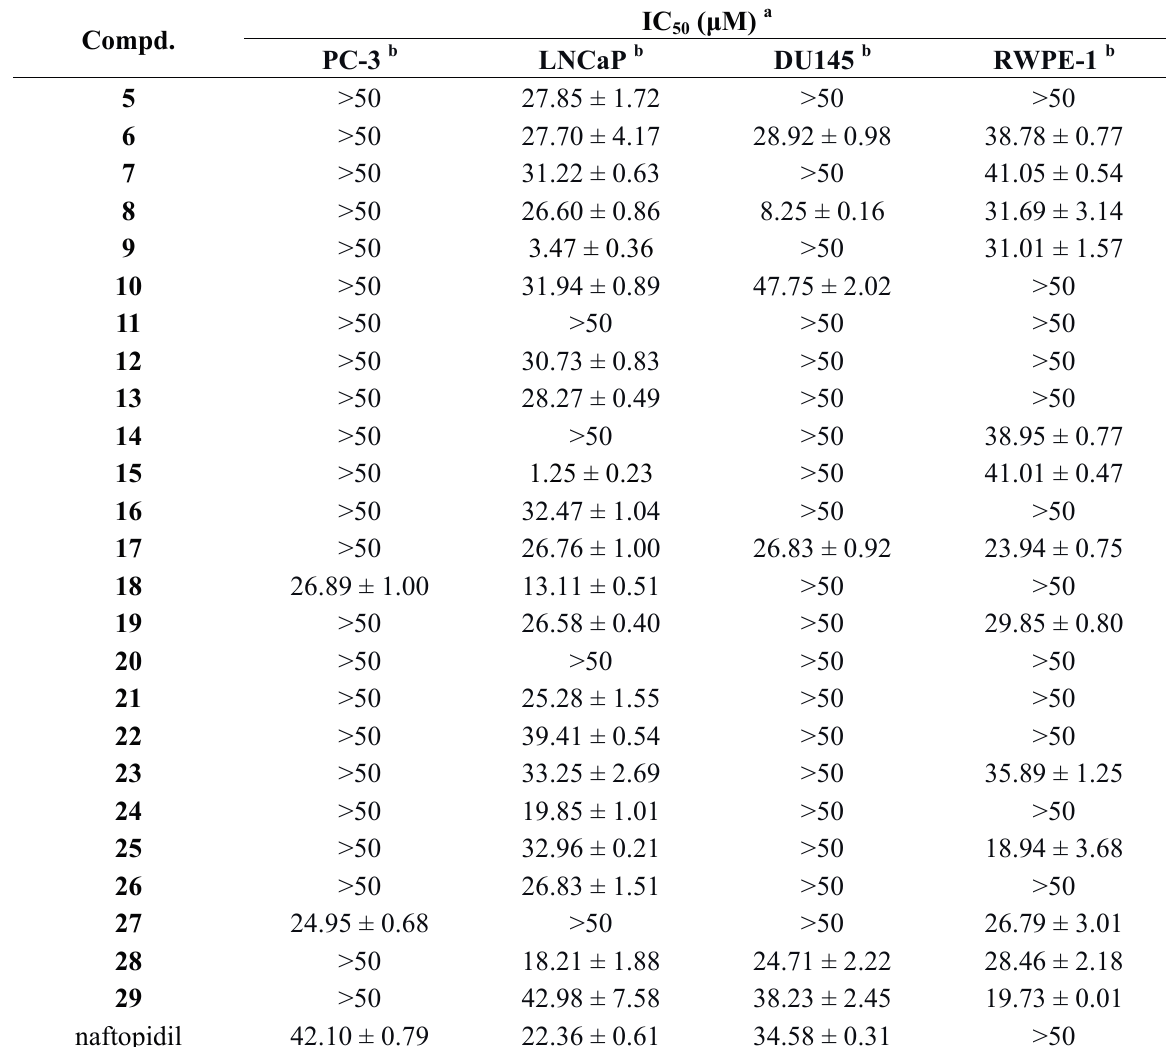
Table 1. In vitro cytotoxicity of compounds 5 – 29